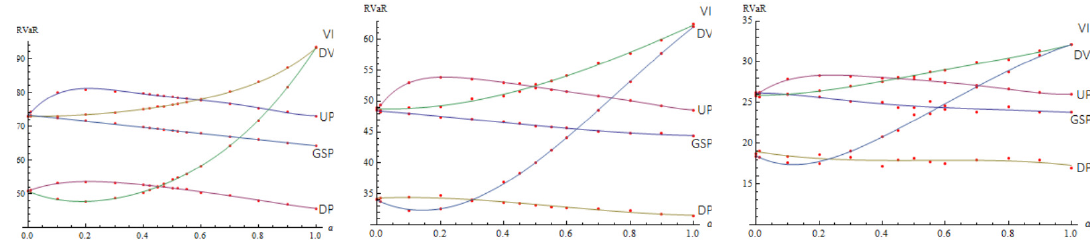
Figure 2. RVaR 0.95 in the four main two objects auction mechanisms plus GSP with 3.5 and 10